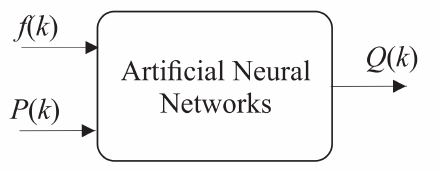
Figure 7. Diagram of Multi-layer Feedforward Backpropagation ANN without feedback, with two input vectors and an output.